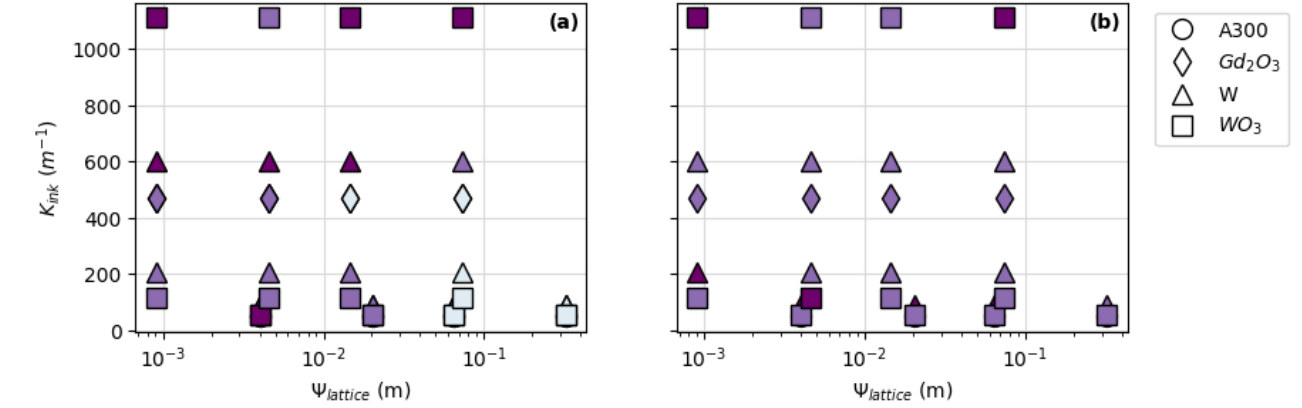
Figure 9. Ink rheology (K ink ) vs. lattice parameter ( Ψ lattice ) for: ( a ) FCT prints and ( b ) SC prints. The